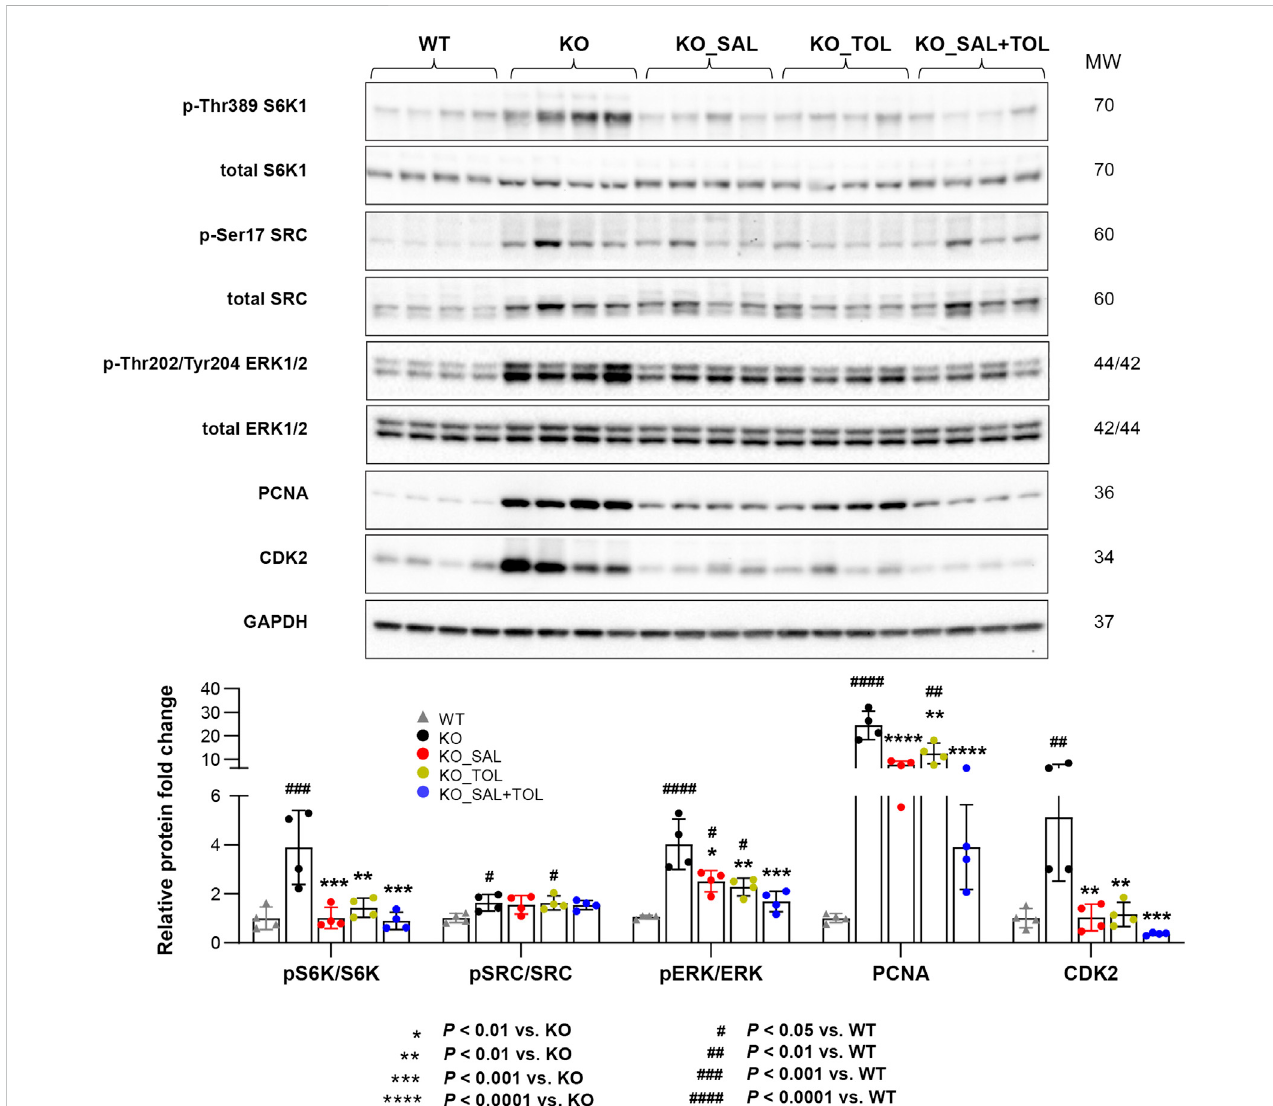
FIGURE 2 The combined treatment attenuated expression of pathogenic mediators in Pkd1 mutant mouse kidneys. The phosphorylation levels of S6K1, SRC, and ERK1/ERK2,aswellasthetotalproteinlevelsofPCNAandCDK2inWT,untreatedandtreatedmutantmousekidneysbyWesternblotting.GAPDHwasusedas a loading control. The mutant kidneys were selected around the median of 2 KW/BW% from each